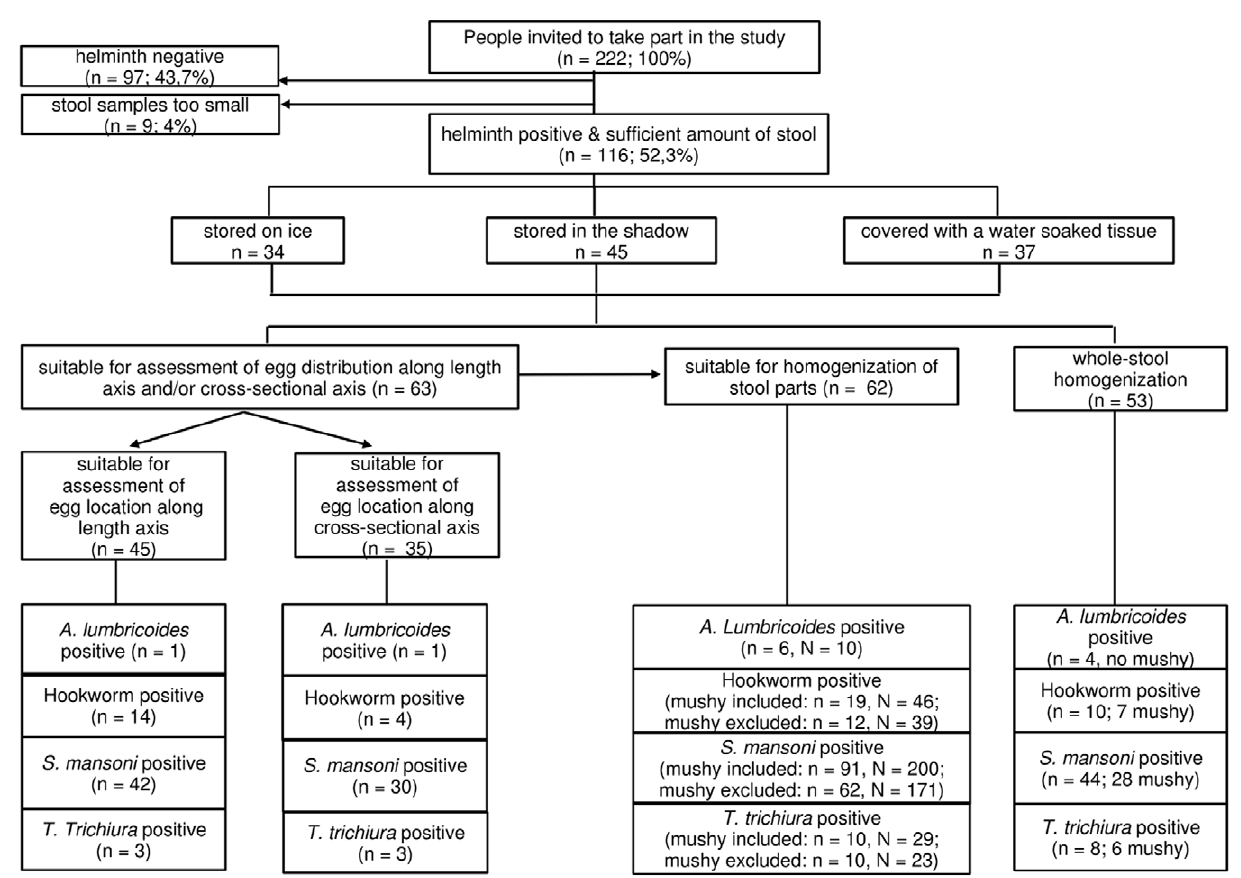
Figure 3. Flowchart detailing inclusion and exclusion of study participants and use for the various analysis including helminth prevalences. n, number of whole-stool samples; N, number of stool pieces.